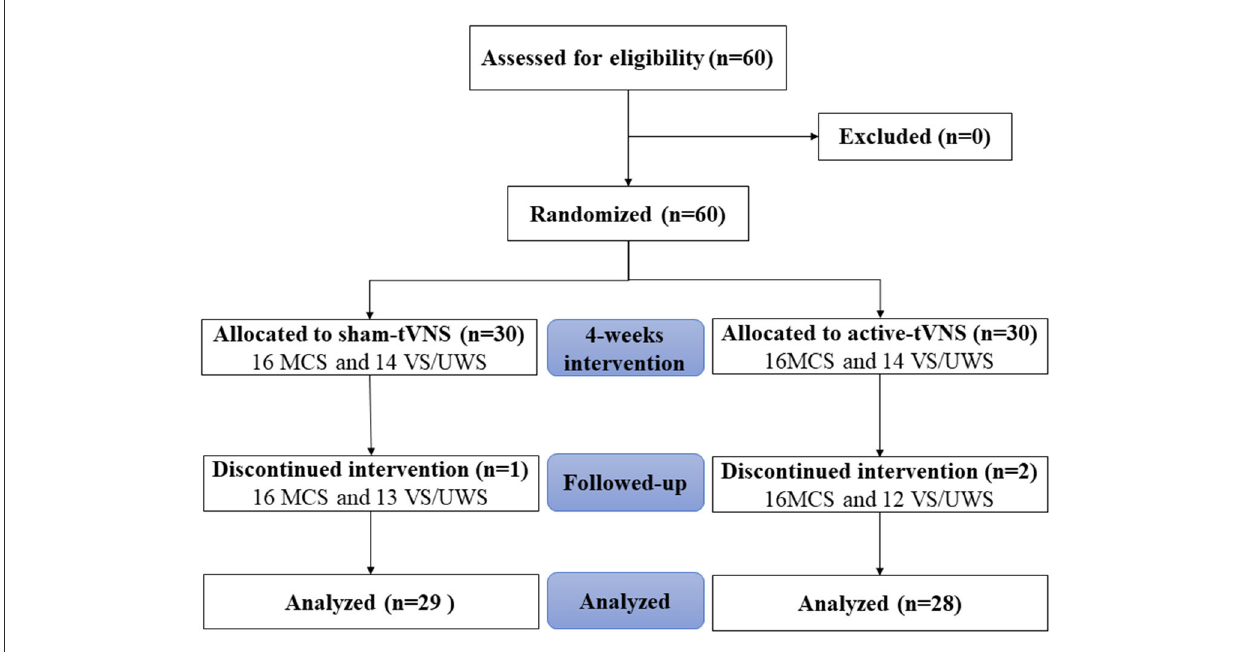
FIGURE1 CONSORT flow